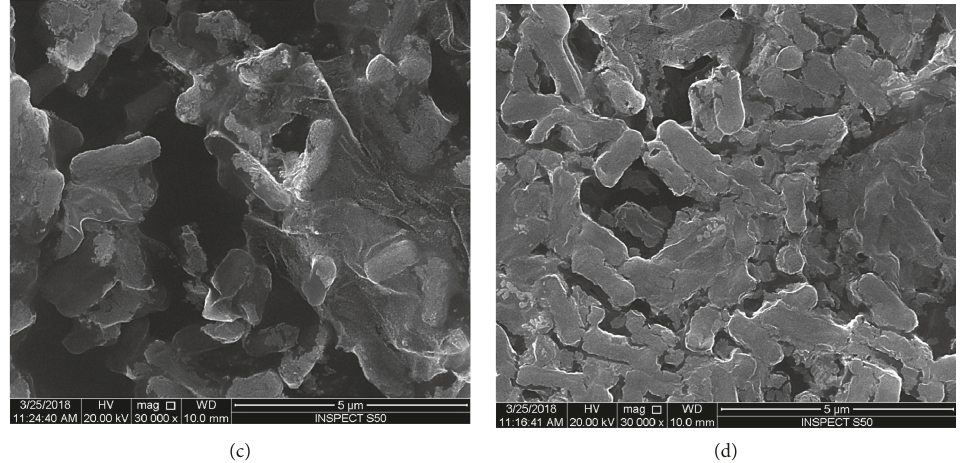
F IGURE 7: Scanning micrograph of E. coli treated with compound 4d at a concentration of 1mg/ml (a, b), 2 mg/ml (c), and 4mg/ml (d). (a) is shown at lower magnification and (b)–(d) at higher